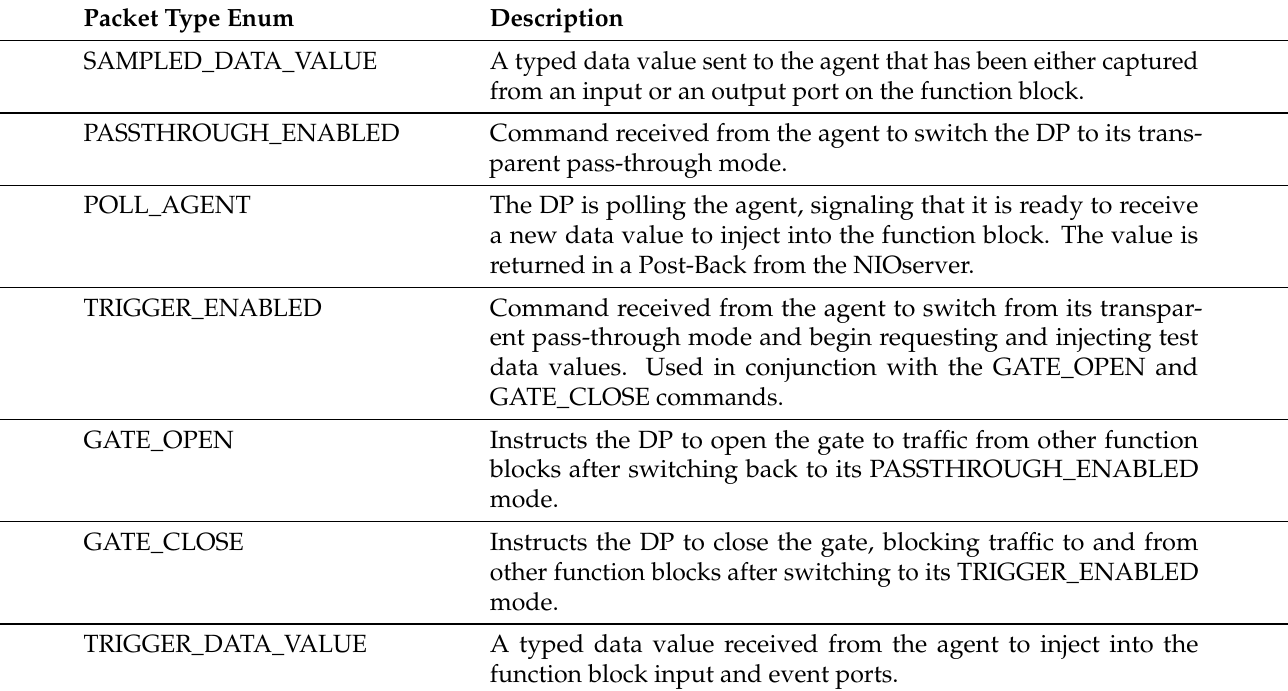
Table 2. Packet Type Commands used to control and exchange data with Diagnostic